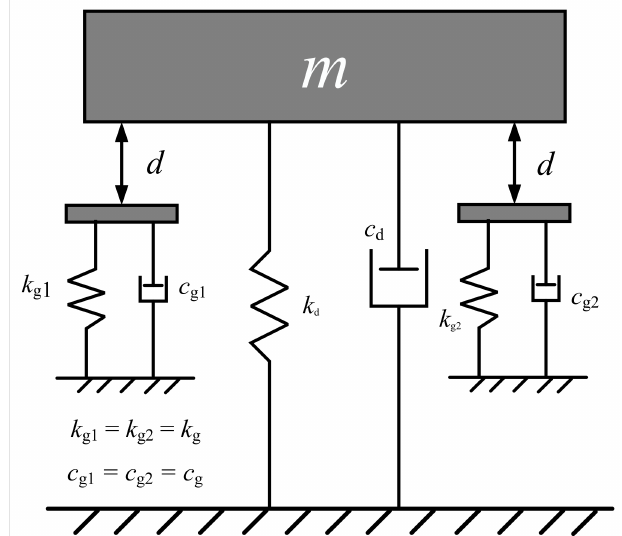
Figure 14. SDOF piecewise linear model